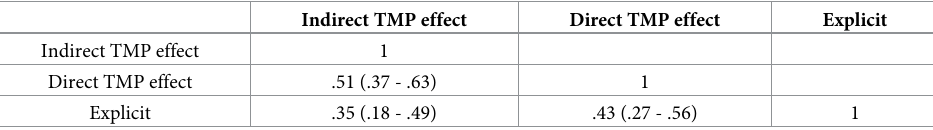
Table 4. Correlations between measures for scores based on “are-vs-should” relations. All p s for correlations <